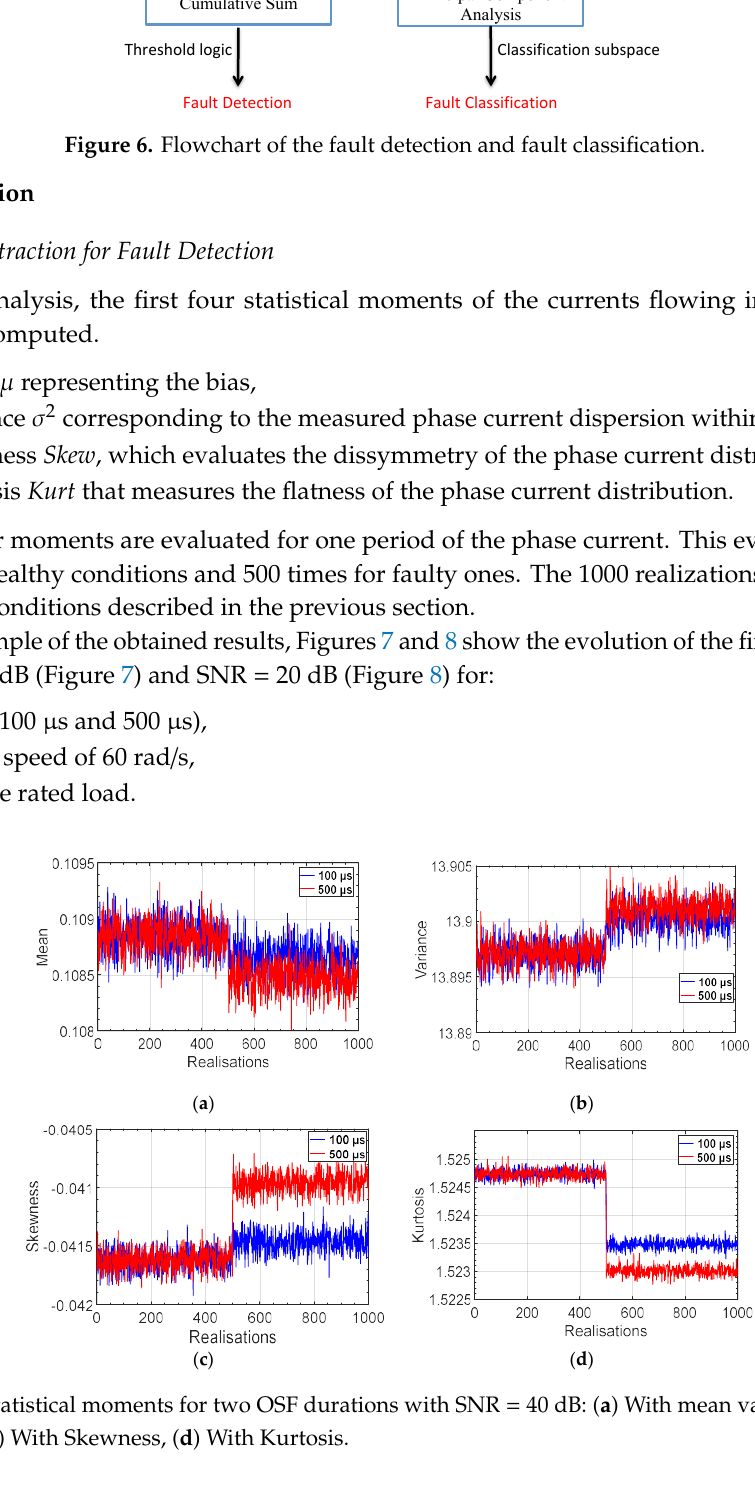
variance, ( c ) With Skewness, ( d ) With Kurtosis.